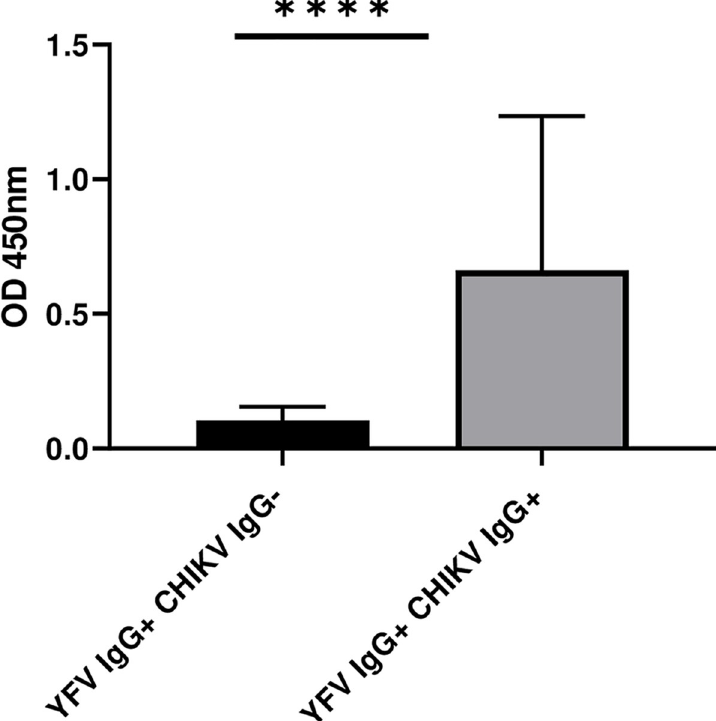
Fig 5. Comparison of the OD values of YFV IgG + samples stratified by the presence or absence of CHIKV IgG antibody (CHIKV IgG + or IgG - ).